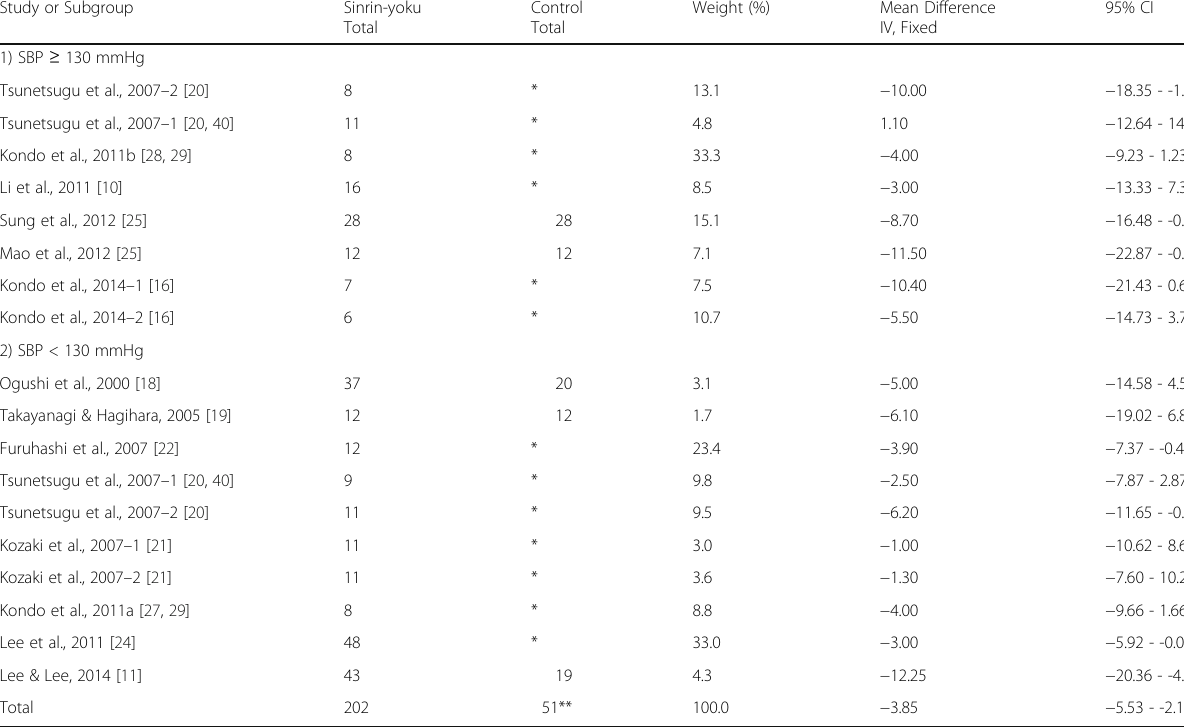
Table 2 Results of the meta-analysis of the change in SBP (mmHg) in the two subgroup analyses of SBP levels of 1) ≥ 130 and 2) < 130 mmHg before the